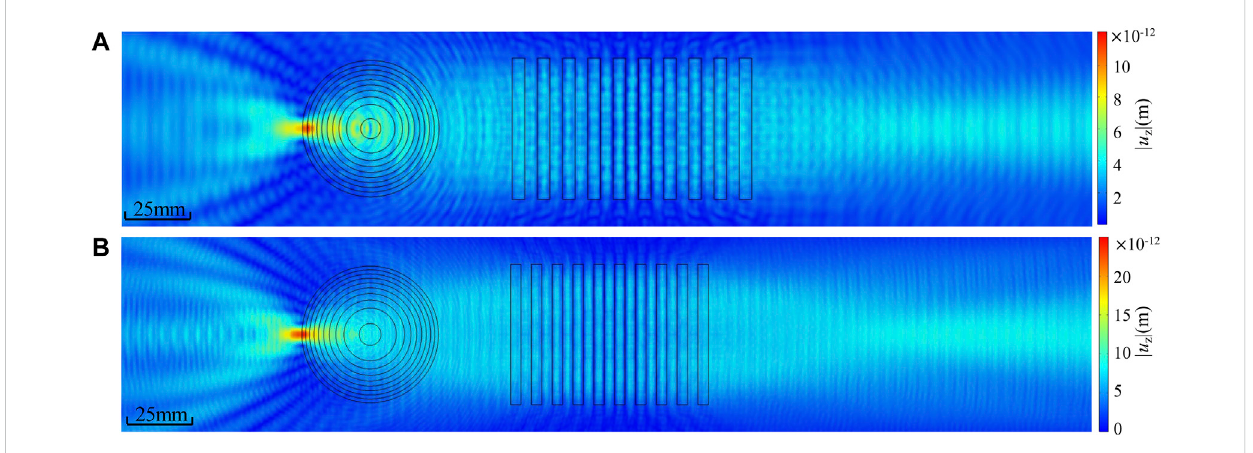
FIGURE 8 Spatial energy distribution represented by | u z | of (A) the A1-wave-based Luneburg lens at 1 MHz, and (B) the S2-wave-based Luneburg lens at 1.9 MHz.